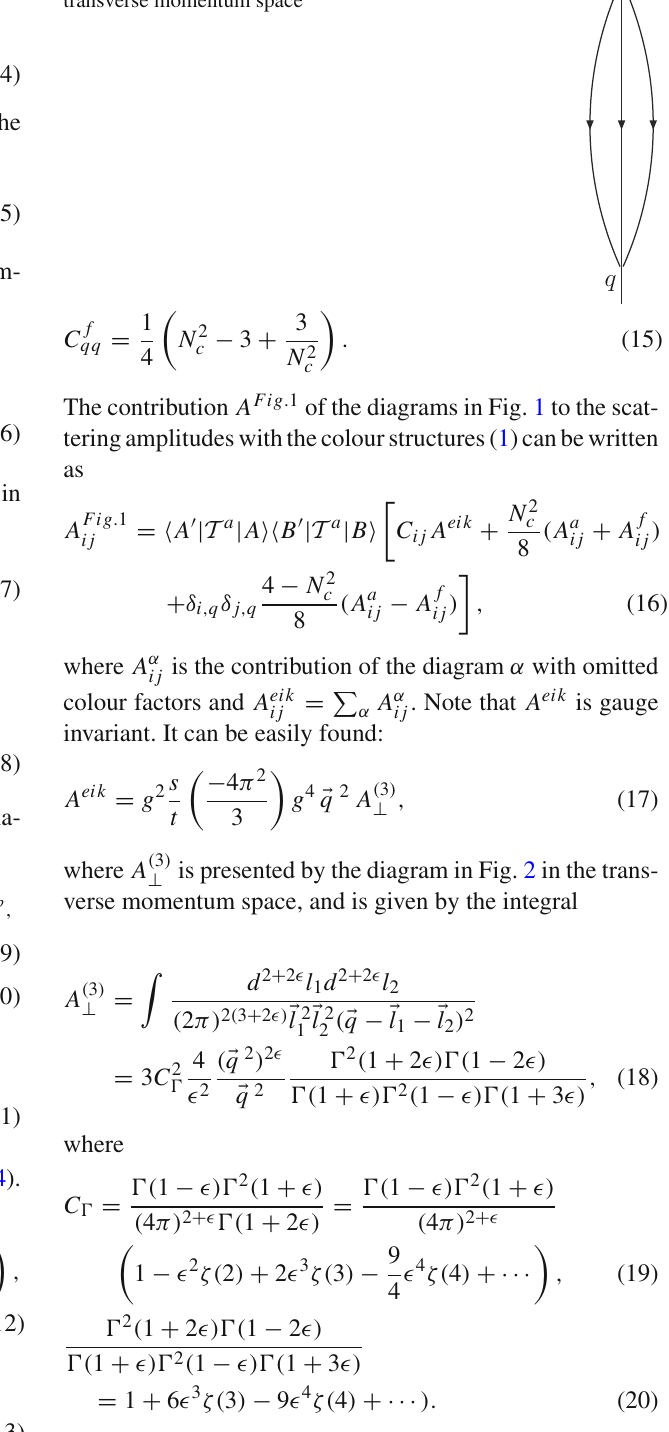
Fig. 2 Diagrammatic ( 3 ) representation of A ⊥ in the transverse momentum space